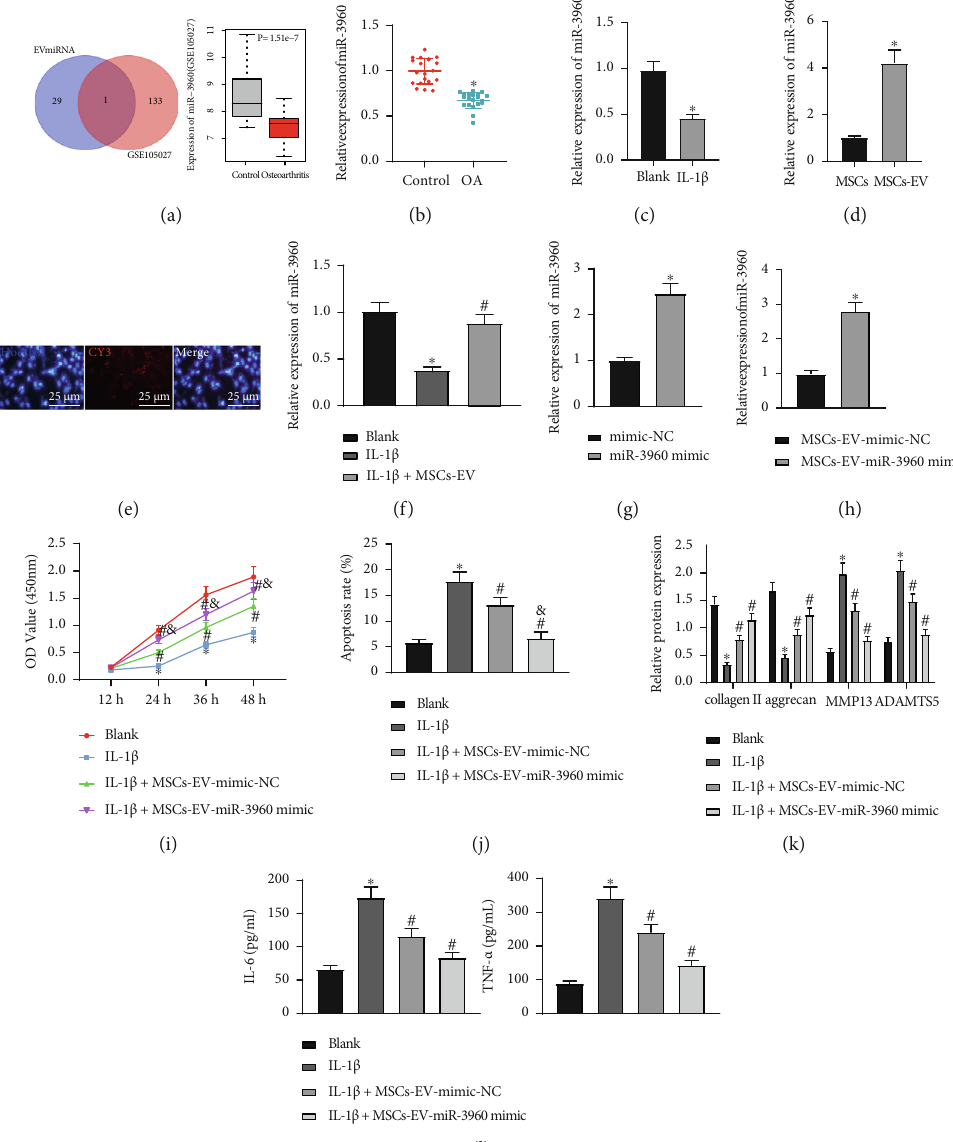
Figure 2: MSCs-EVs carrying miR-3960 inhibits chondrocyte injury in OA. (a) Venn diagram of 134 downregulated miRNAs (red circle) in GSE105027 dataset and the top 30 miRNAs enriched in MSCs-EVs (blue circle) and miR-3960 expression in GSE105027 dataset. (b) miR- 3960 expression in the cartilage tissues of OA patients ( n = 20 ) and patients with traumatic amputation ( n = 20 ) determined by RT-qPCR. (c) miR-3960 expression in the IL-1 β -treated chondrocytes determined by RT-qPCR. (d) The expression of miR-3960 in MSCs-EVs was determined by qRT-PCR ( p < 0 : 05 vs. that in MSCs). (e) Transfer of Cy3-labeled miR-3960 into chondrocytes via MSCs-EVs ( scale bar = 25 μ m ). (f) miR-3960 expression in the chondrocytes treated with IL-1 β +MSCs-EVs determined by RT-qPCR. (g) miR-3960 expression in the chondrocytes treated with miR-3960 mimic determined by RT-qPCR. (h) miR-3960 expression in the chondrocytes treated with IL-1 β +MSCs-EVs-miR-3960 mimic determined by RT-qPCR. Chondrocytes were treated with IL-1 β and/or MSCs-EVs- miR-3960 mimic. (i) Cell proliferation assessed by CCK8 assay. (j) Apoptosis assessed by fl ow cytometry. (k) Protein levels of collagen II, aggrecan, MMP13, and ADAMTS5 in chondrocytes measured by immunoblotting. (l) Levels of IL-6 and TNF- α in chondrocytes measured by ELISA. ∗ p < 0 : 05 vs. patients with traumatic amputation, chondrocytes without treatment, chondrocytes treated with mimic-NC, or chondrocytes treated with MSCs-EVs-mimic-NC; # p < 0 : 05 vs. chondrocytes treated with IL-1 β ; & p < 0 : 05 vs. chondrocytes treated with IL-1 β +MSCs-EVs-mimic-NC. Data are shown as the mean ± standard deviation of three technical replicates. Data between two groups were compared by independent t -test. Data comparisons among multiple groups were analyzed by the one- way ANOVA with Tukey ’ s post hoc test, and comparison of data at di ff erent time points was analyzed using repeated measurement ANOVA with Tukey ’ s post hoc